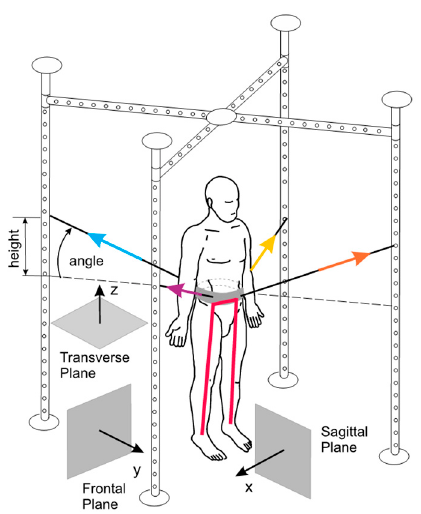
Figure 1. SPIDER (strengthening program of intensive developmental exercises and activities for reaching maximal potential) equipment (SPIDER net) with the reference planes, the expander forces in the standard anatomical position.